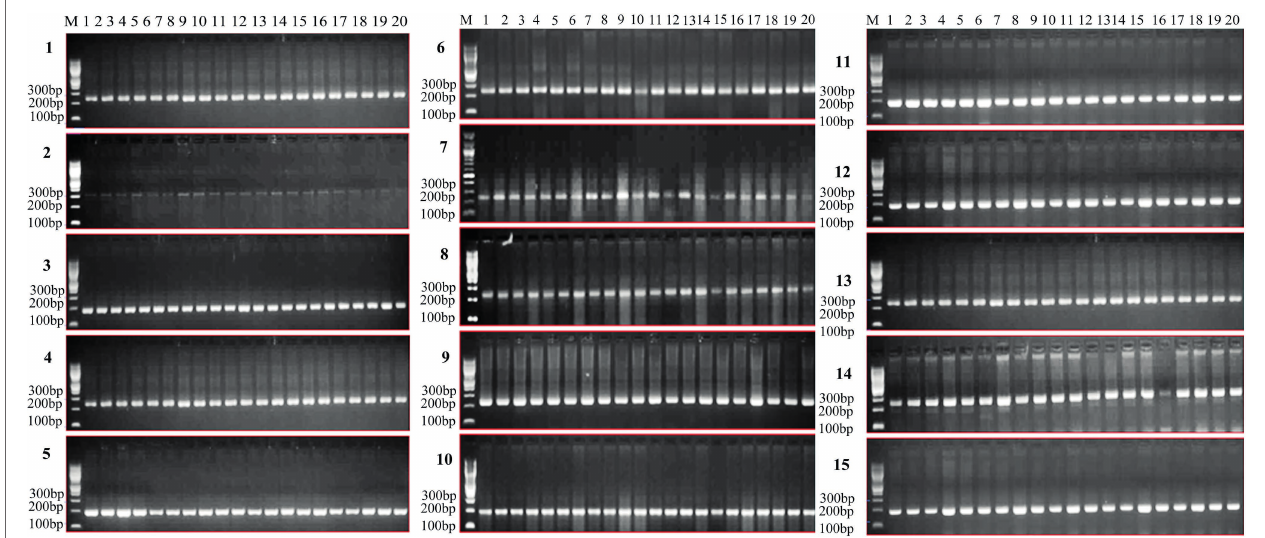
FIGURE 7 | Gel pictures depicting the expression of identified genic SSRs in highly diverse wheat genotypes (1-UP2425, 2-WR544, 3-SONARA64, 4-K7903 (HALNA), 5-WH730, 6-DBW14, 7-RAJ4014, 8-DBW71, 9-AKAW1071, 10-RAJ3765, 11-NIAW34, 12-NW1014, 13-K9465, 14-K9644, 15-HD2733, 16-K9107, 17-PBW502, 18-DBW17, 19-RAJ4083, and 20-WH542) for heat